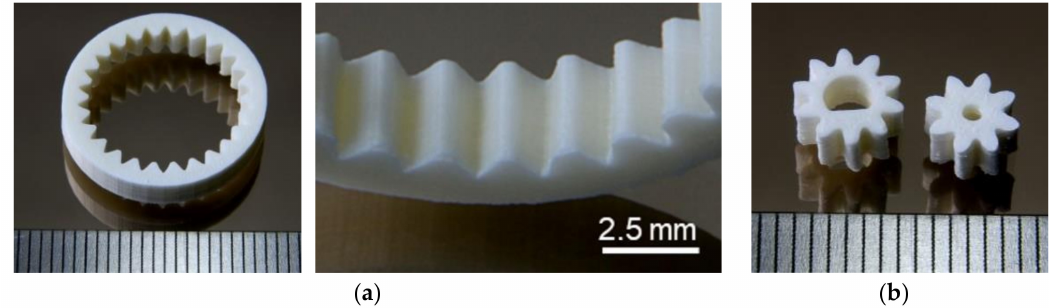
Figure 7. Sintered alumina parts: ( a ) Complete ring gear and structure details and ( b ) gear wheels.